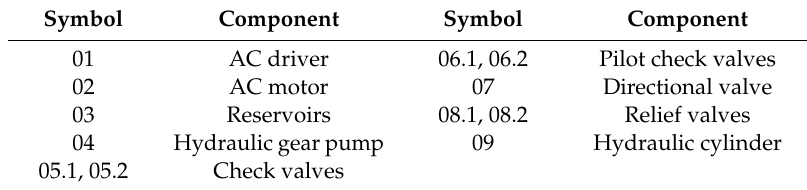
Figure 1. Schematic of the PCEHS. Table 1. Components of the PCEHS.